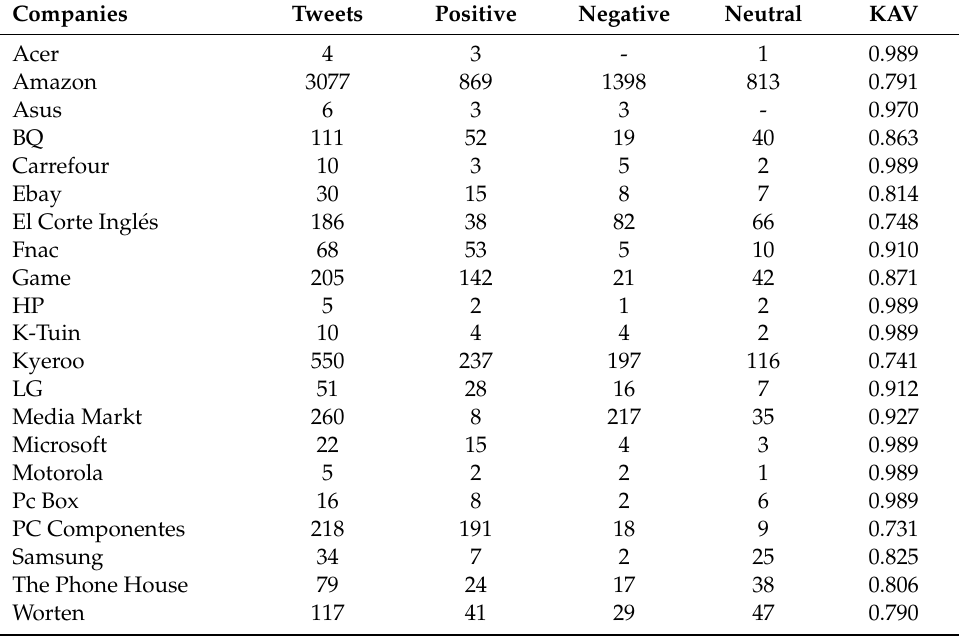
Table 4. Results of sentiment analysis and average